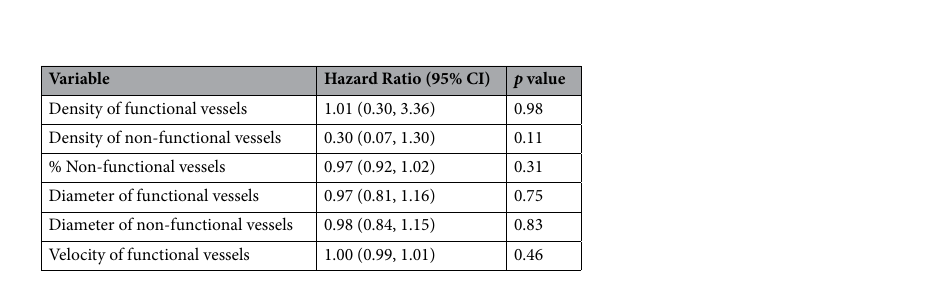
Table 4. Univariate analysis of tumor vessel characteristics with disease-specific survival among patients who had received neoadjuvant therapy (n =